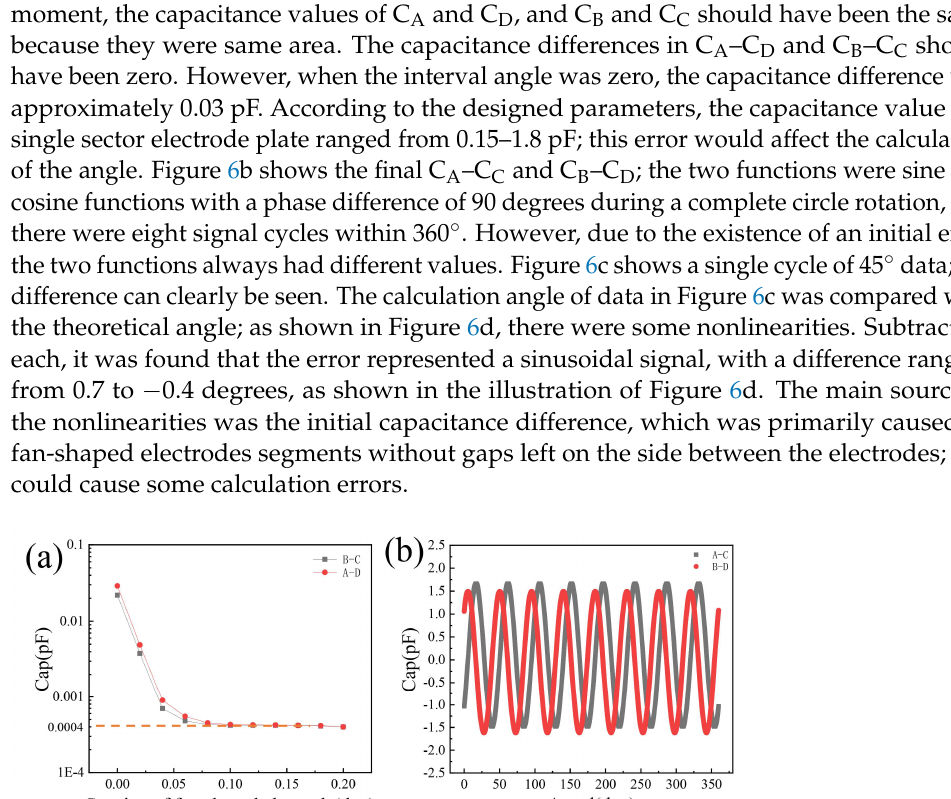
Figure 7. The improved COMSOL simulation results: ( a ) a single cycle of 2π/X (45°); ( b ) curves of C A –C C and C B –C D ; ( c ) improved calculation angle and theoretical angle; and ( d ) the error compari- son.